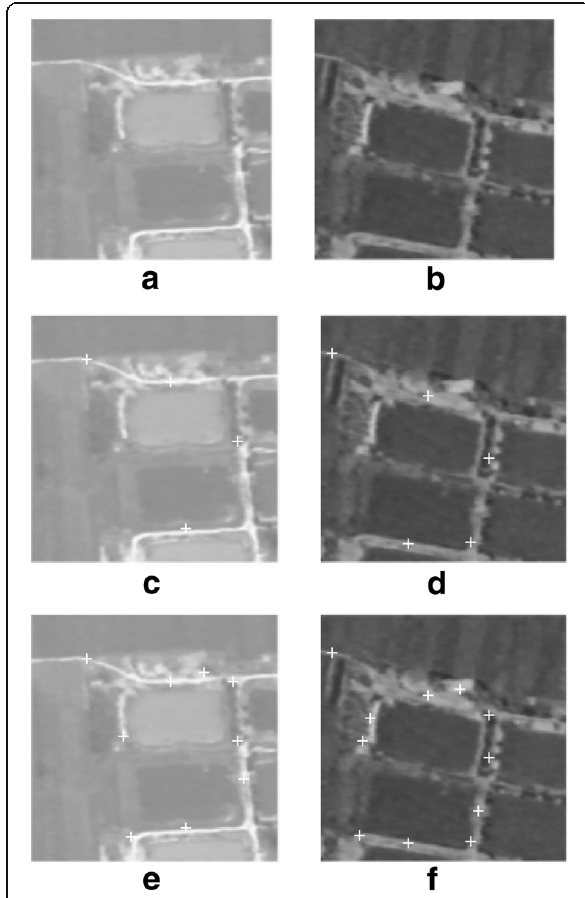
Fig. 3 The detection of visual salient region center based on entropy priority. a Visible light image. b Infrared image. c The result based on salient degree for a . d The result based on salient degree for b . e The result based on entropy priority for a . f The result based on entropy priority for